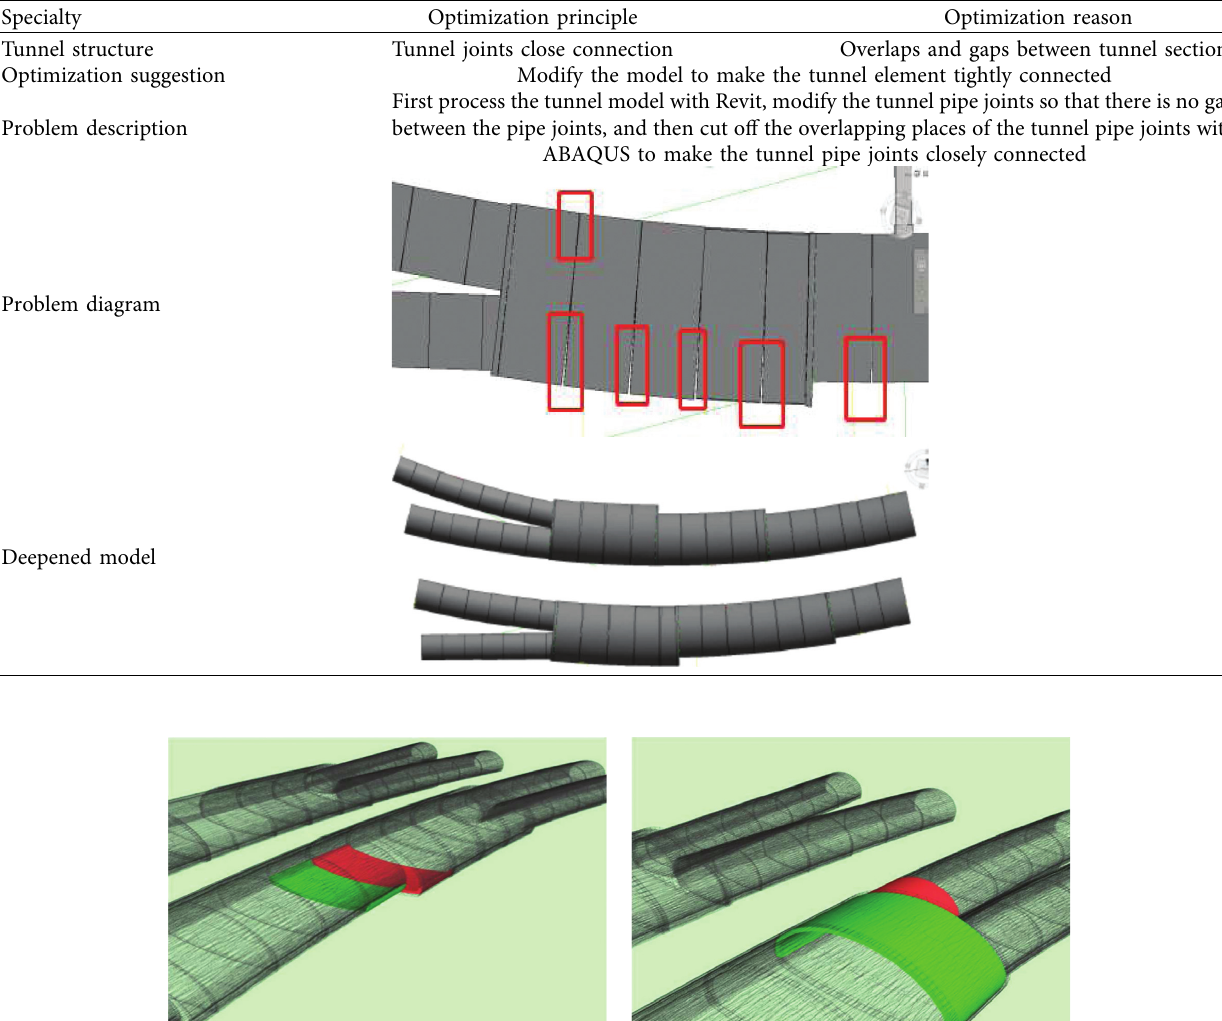
Table 2: Professional internal deepening table.